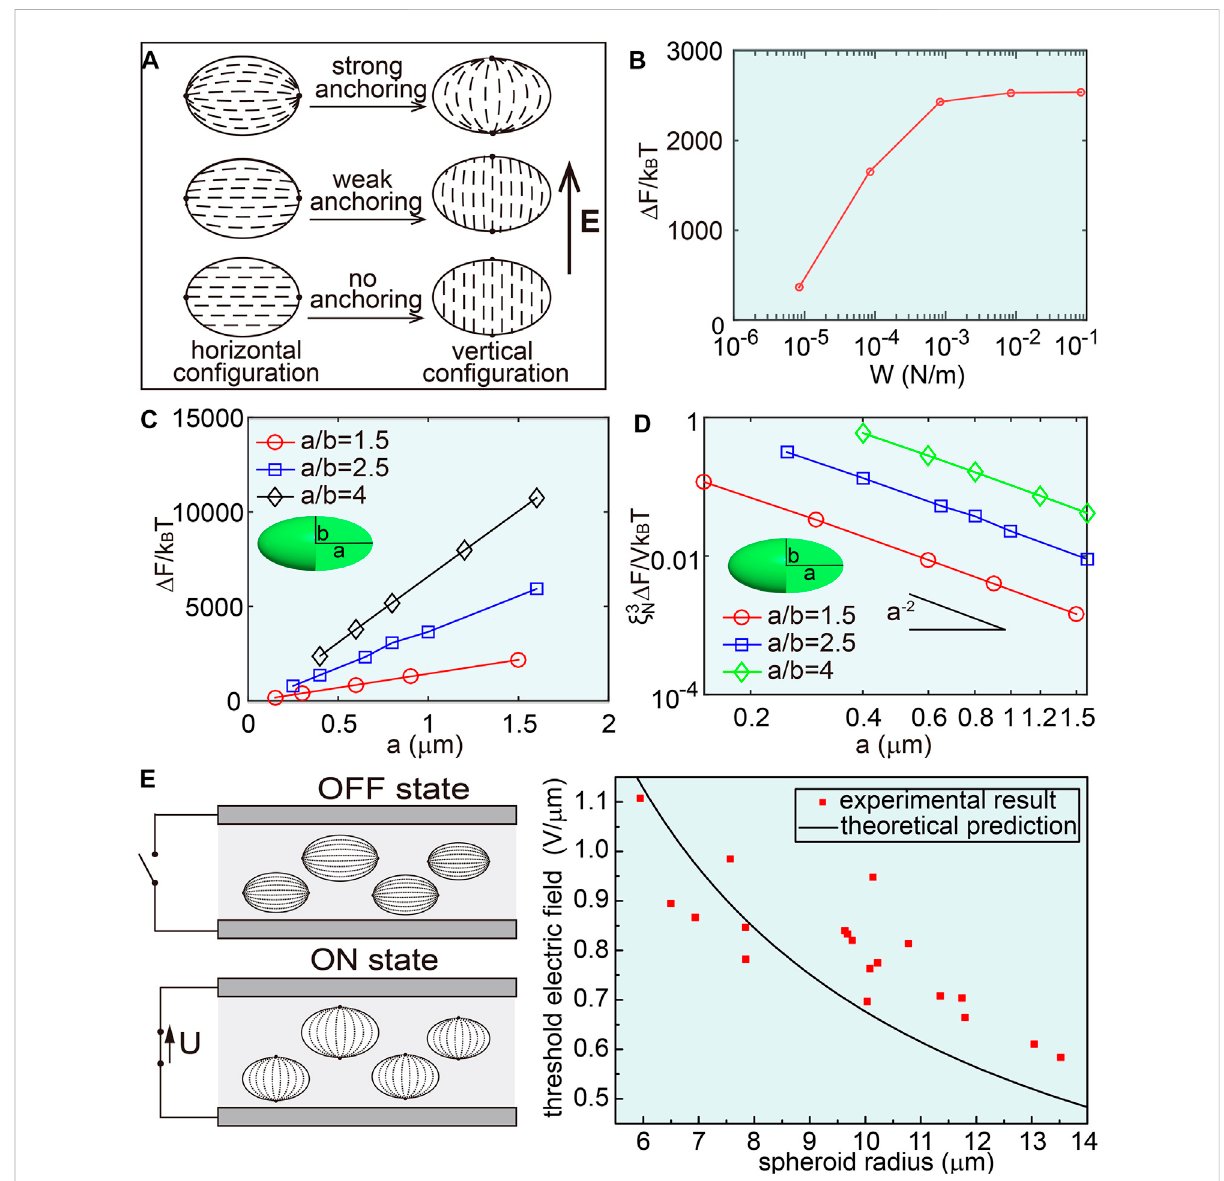
FIGURE 3 Energy landscape of the bipolar structure and electric switching between the horizontal and vertical con fi gurations. (A) Model of director reorientation of oblate nematic LC spheroid under different planar anchoring strength when a threshold electric fi eld is applied. (B) The free energy difference between the horizontal and vertical con fi gurations increases as the planar surface anchoring strength increases. When the surface anchoring strength is large enough, the free energy difference reaches a plateau. (C) Under a strong planar surface anchoring strength ( W = 0.1 N/m), the free energy difference increases when the aspect ratio of the spheroid increases or the size of the spheroid increases. (D) The free energy density difference decreases when the size of spheroid increases. (E) Dependence of the threshold electric fi eld required to reorient the nematic spheroid on the size of the spheroid. The red square dots are experimental results, while the black curve is the theoretical